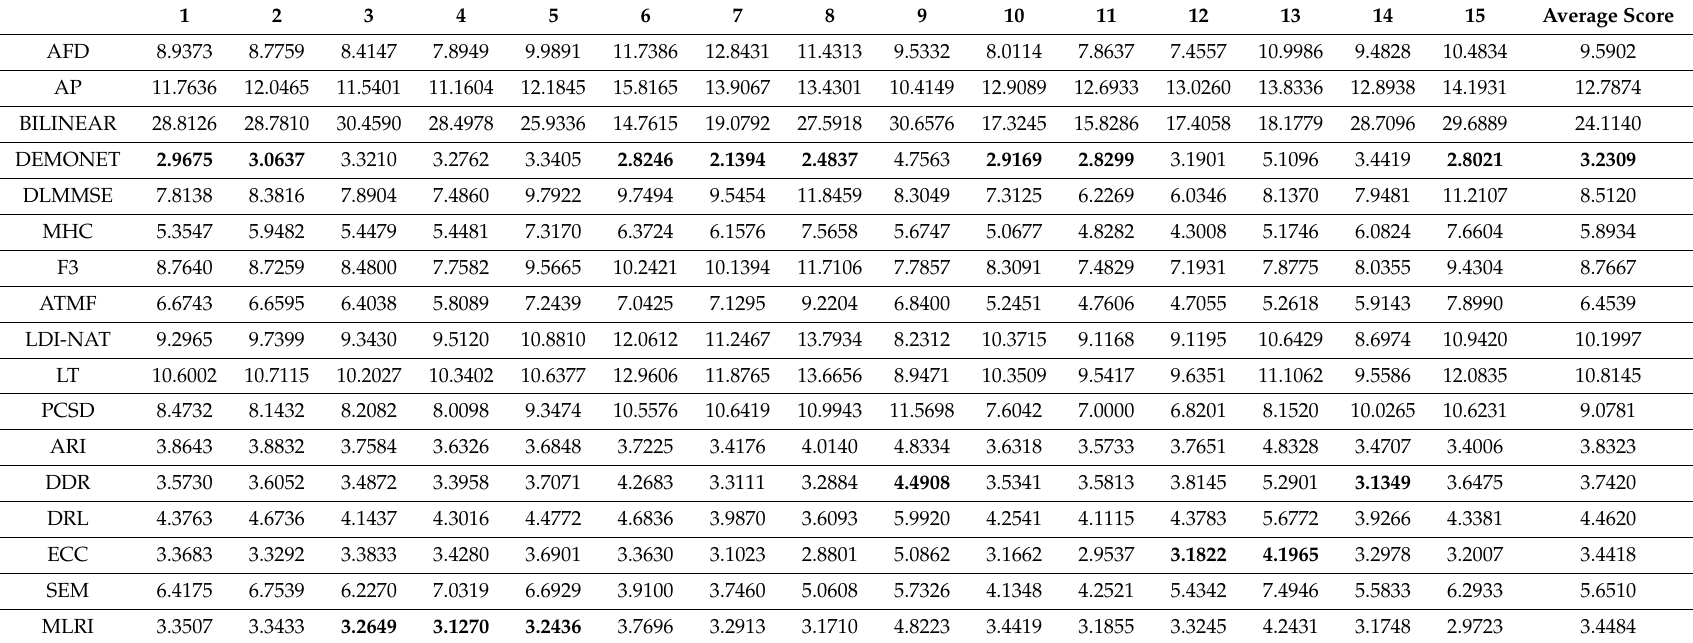
Table 5. Summary of NIQE scores (lower = better). Fifteen right images: Red